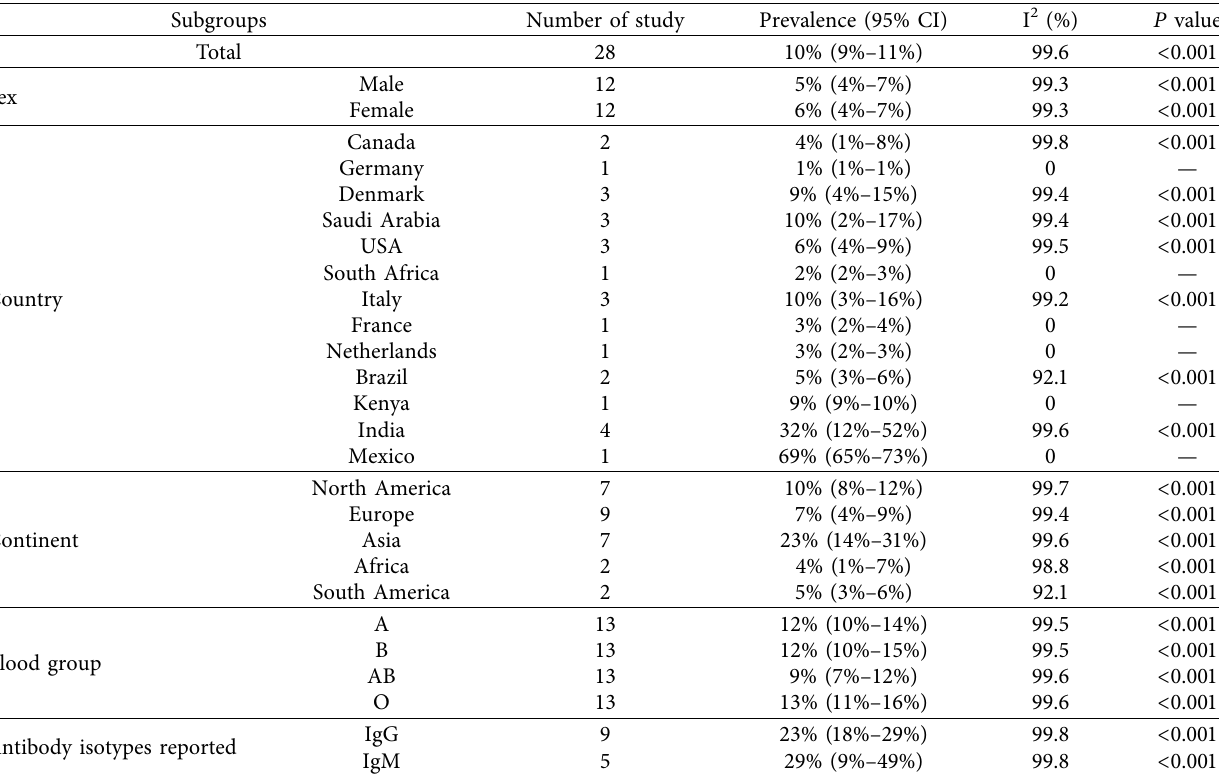
Table 2: Seroprevalence of COVID-19 in blood donors in the studied